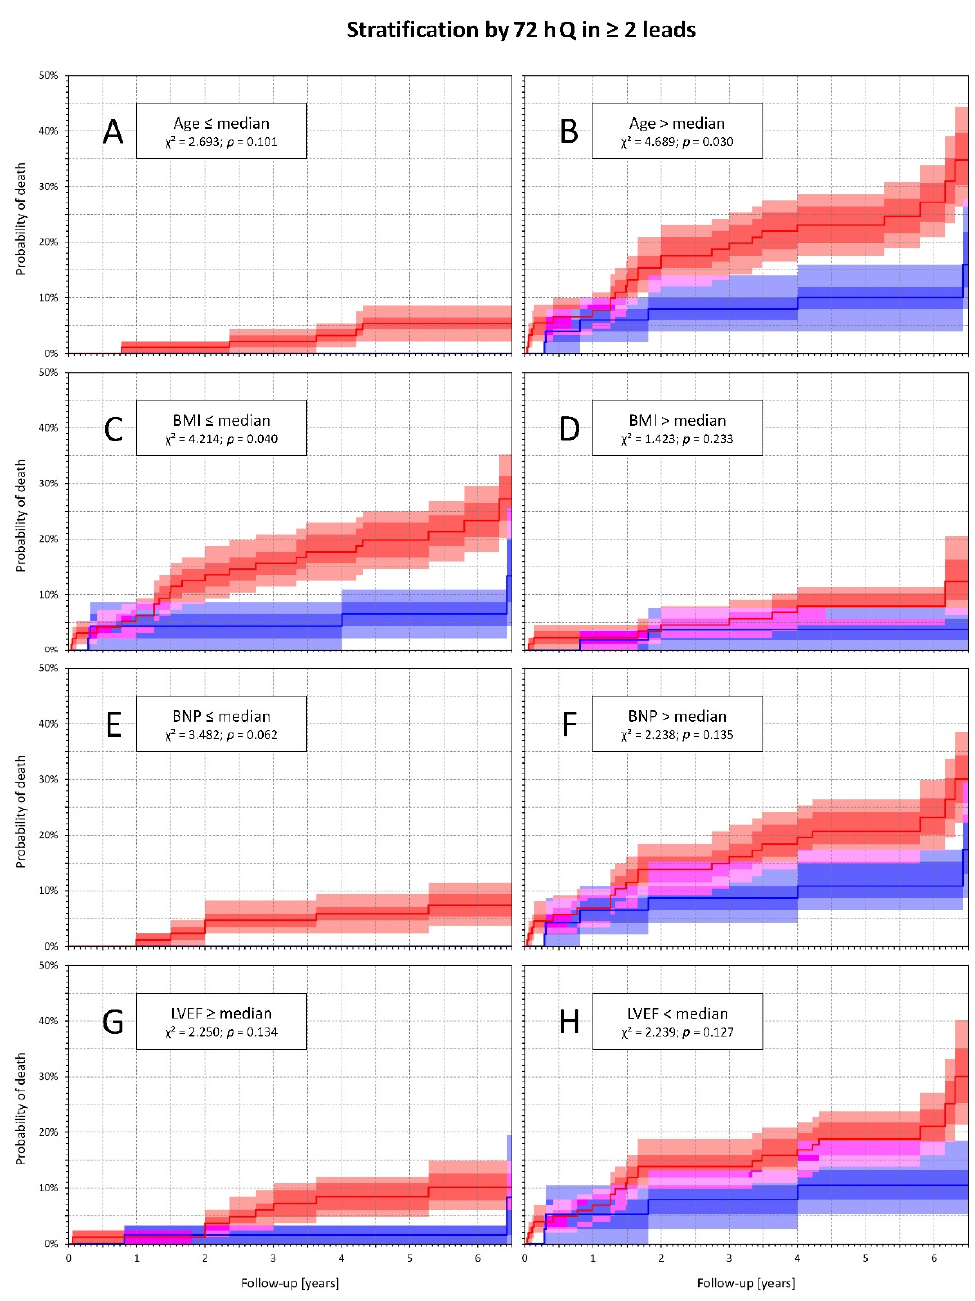
Figure 3. Kaplan–Meier analysis of probability of death in subpopulations defined by various clinical variables dichotomized at population medians and further dichotomized by the presence or absence of 72 h Q wave. The panels show comparisons in particular subpopulations dichotomized by the presence of 72 h Q wave (red line) or absence of 72 h Q wave (blue line): panel ( A )—age below median, there were no deaths for age below median without 72 h Q wave; panel ( B )—age above median; panel ( C )—BMI below median; panel ( D )—BMI above median; panel ( E )—BNP below median, there were no deaths for BNP below median and without 72 h Q wave; panel ( F )—BNP above median; panel ( G )—LVEF above median; panel ( H )—LVEF below median. In all panels, inter-quartile ranges are shown as the darker areas and 90% confidence intervals as the lighter areas.